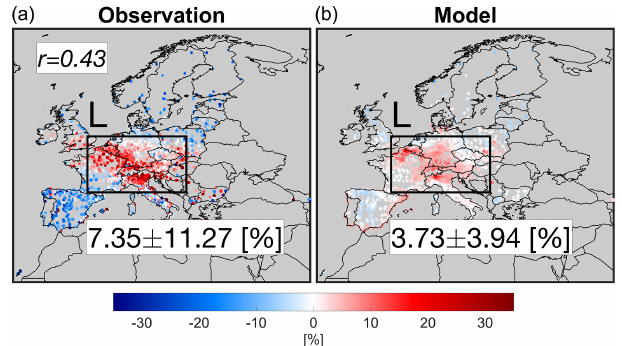
Figure 6. Changes in surface MDA8 ozone concentrations sug- gested by the observation (a) and the constrained model (b) in April 2020 relative to those in 2019. The numbers are based on the box L